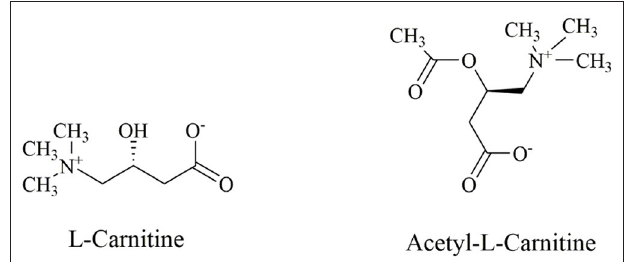
FIGURE 1 | The structural formula of L-carnitine and